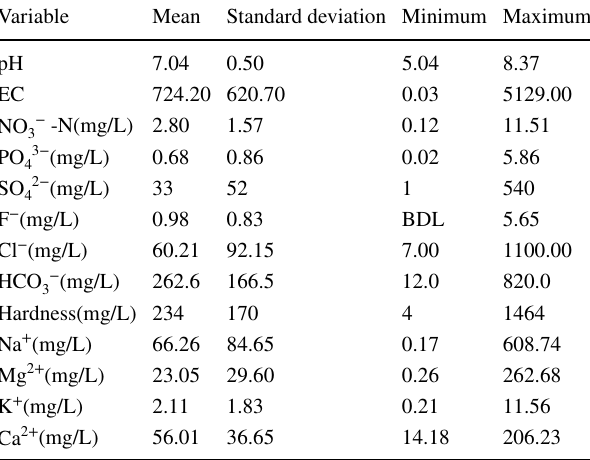
Table 2 Descriptive statistics of the water quality parameters of the study